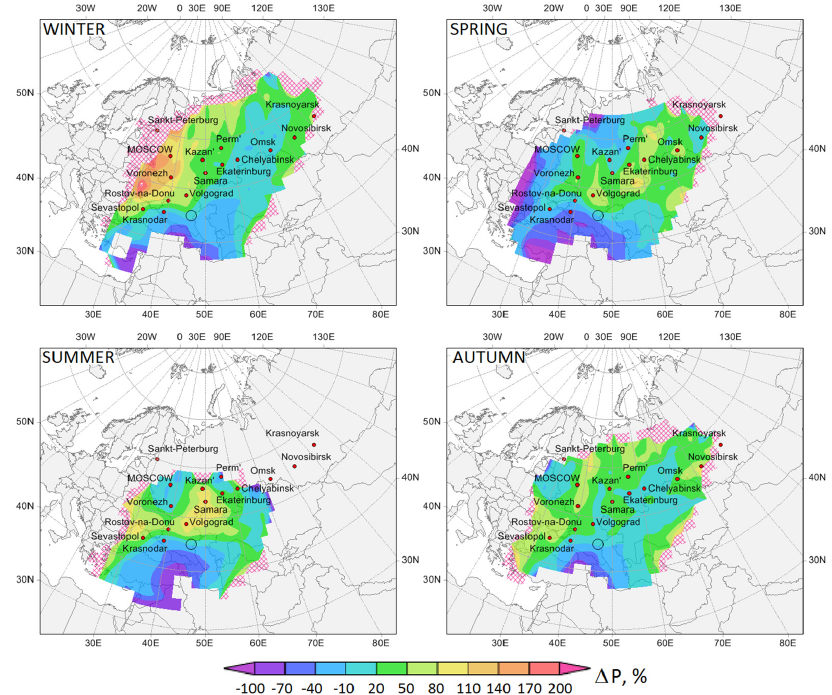
Figure 15. Change in the average seasonal probability of air particles transport, Δ P [%], from the boundary layer over the deserted lands of Kalmykia in 2005–2018 compared with 1991–2004. The magenta shaded areas indicate (here and after) the new transport areas that arose only in the later period. Atmosphere 2021 , 12 , x FOR PEER REVIEW 21 of 26